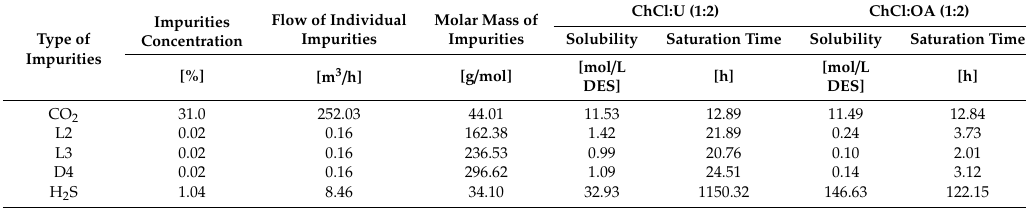
Table 5. List of individual impurities and their solubility in DESs.